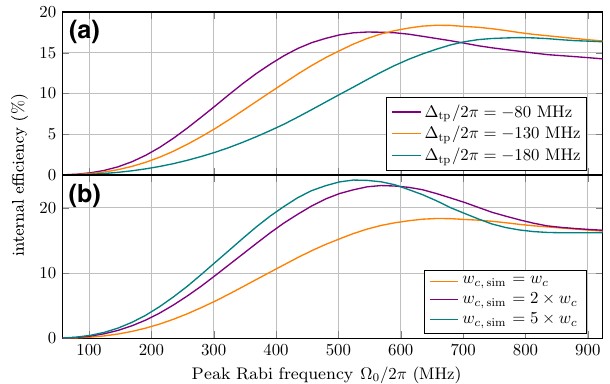
FIG. 5. (a) Simulation of the internal memory efficiency using the known experimental parameters, as a function of the peak control Rabi frequency for different two-photon detunings. (b) Simulation of the internal memory efficiency as above, but for different control beam waists and setting (cid:3) tp / 2 π = − 130 MHz, where w c = 260 ( 3 ) μ m is the experimental waist of the control in the vapor cell